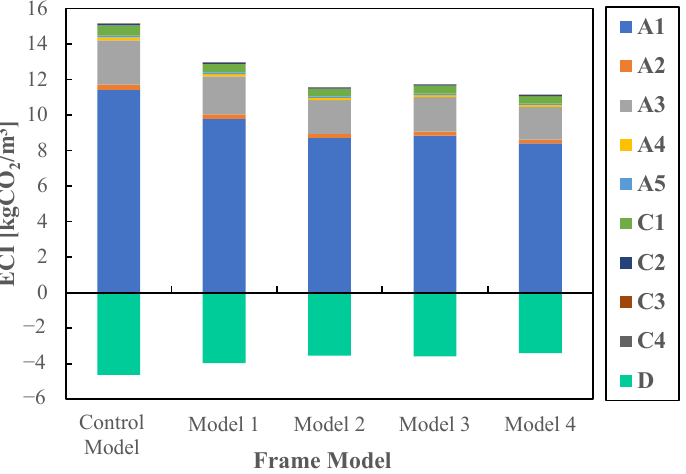
Figure 5. Average contribution of different modules in the ECI for each